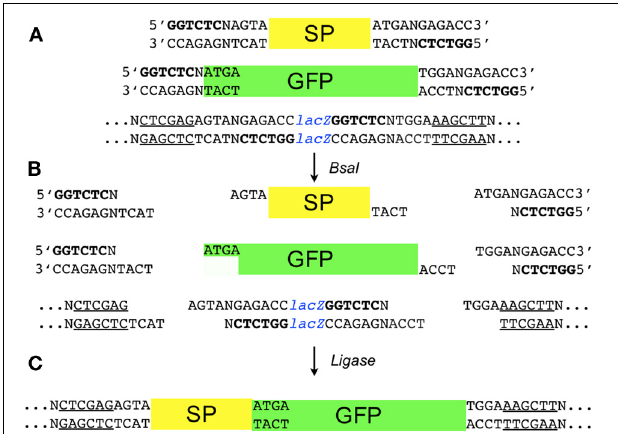
FIGURE A1 | Detail schematic of the two-component assembly using pGoldenGate-SE7 as the destination vector. (A) Synthetic promoter (SP), reporter (GFP), and the pGoldenGate-SE7destination plasmid containing the lacZ α gene are put in the same reaction tube along with BsaI and the T4 DNA ligase. The recognition site for BsaI (5 (cid:2) -GGTCTC-3 (cid:2) ) is shown in bold. The underlined segments are XhoI and HindIII sites flanking the lacZ α gene in the destination vector. (B) Shows the partially single-stranded DNA fragment generated after the digestion with BsaI (C) Ligase is used to assemble the desired product. Note that 5 (cid:2) -ATGA-3 (cid:2) is the first four bps of the GFP coding DNA sequence and therefore this assembly is scar-less.